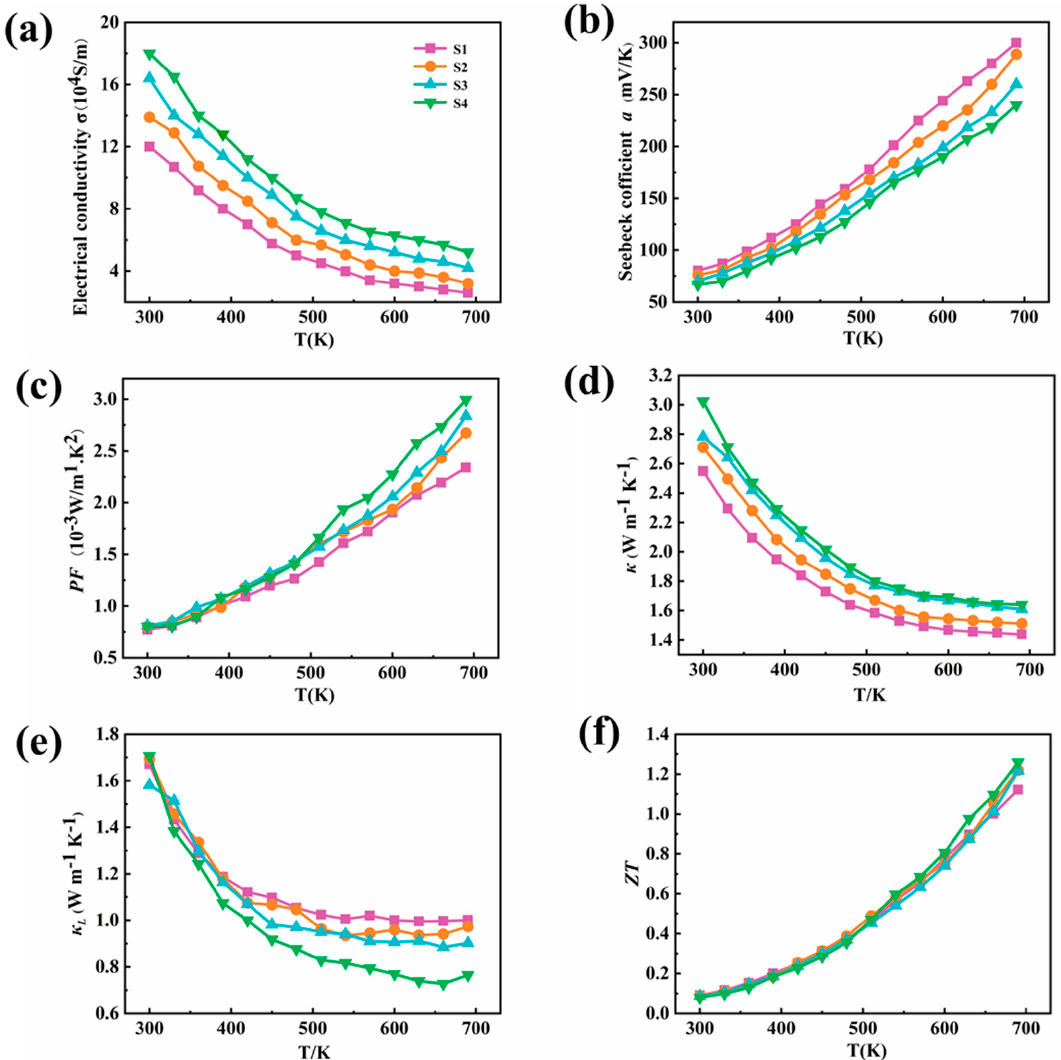
Figure 5. Temperature-dependent ( a ) electrical conductivity, ( b ) the Seebeck coefficient, ( c ) power factor, ( d ) thermal conductivity, ( e ) lattice thermal conductivity and ( f ) figureof merit ZT for PbSe(NaCl) x (x = 3, 3.5, 4, and 4.5).